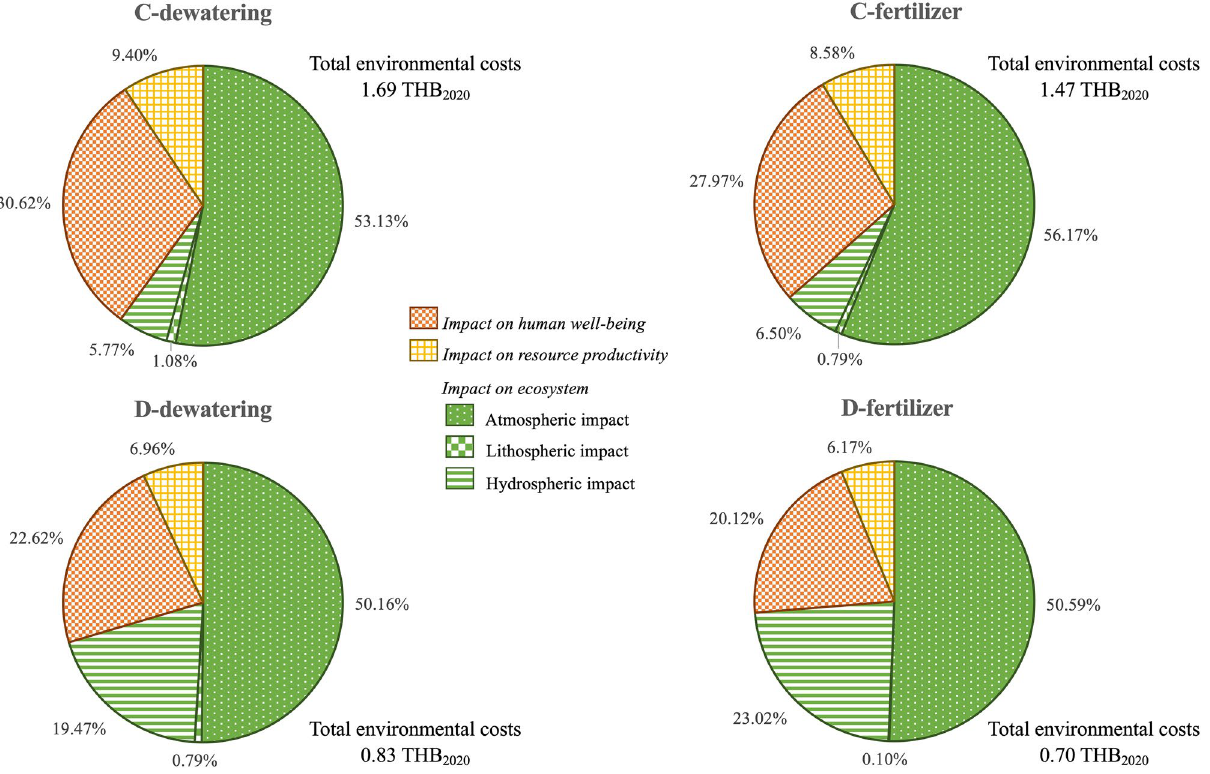
Figure 3. Total environmental costs and three damage categories of four sludge management scenarios.